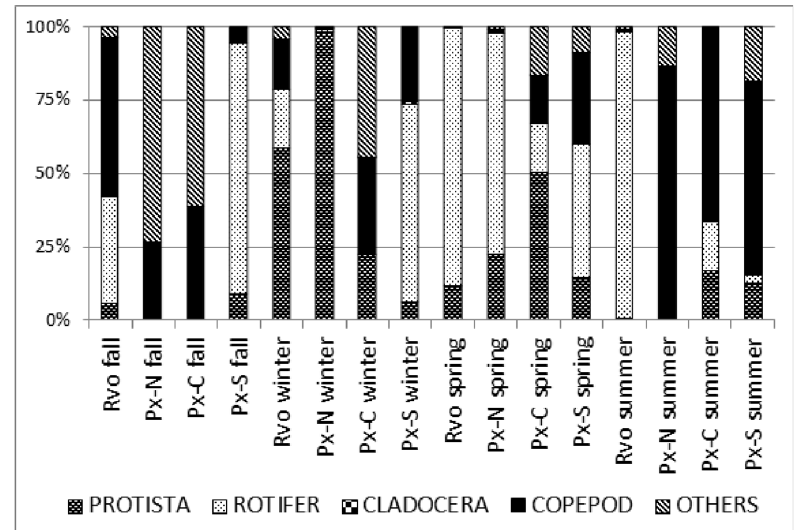
Figure 8 - Relative contribution (%) of density of zooplankton groups in the Ruivo and Peixe lagoons at all sampling dates. (Legend for locations see Table